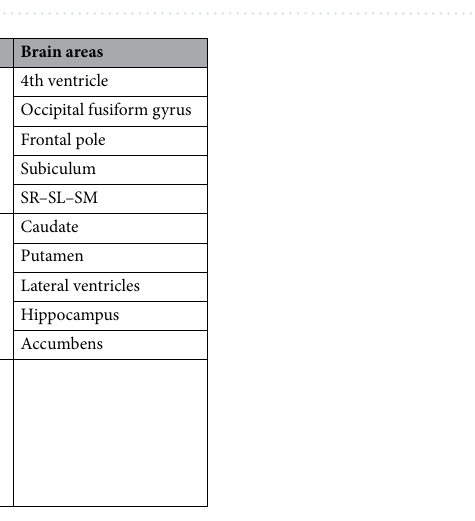
Table 1. Summary of the five most indicative brain areas in the classification of CN and EMCI. CLCVL Cerebellar lobule cerebellar vermal lobules, SR–SL–SM strata radiatum/lacunosum/moleculare.